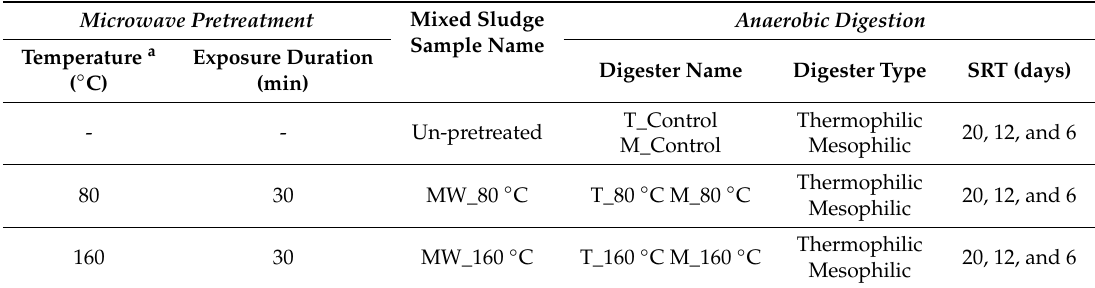
Table 3. Summary of the experimental methodology